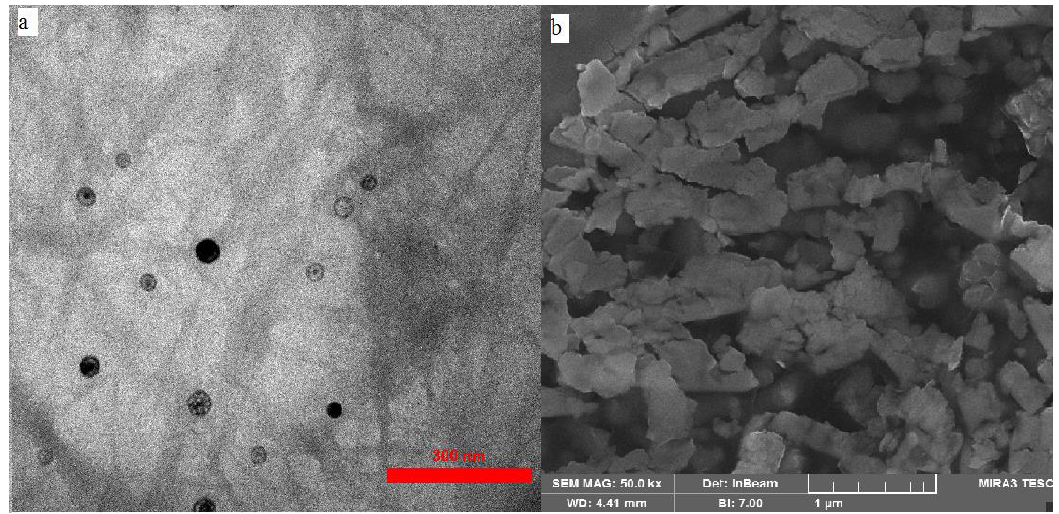
Figure 3. a) TEM image b) FESEM image of the synthesized